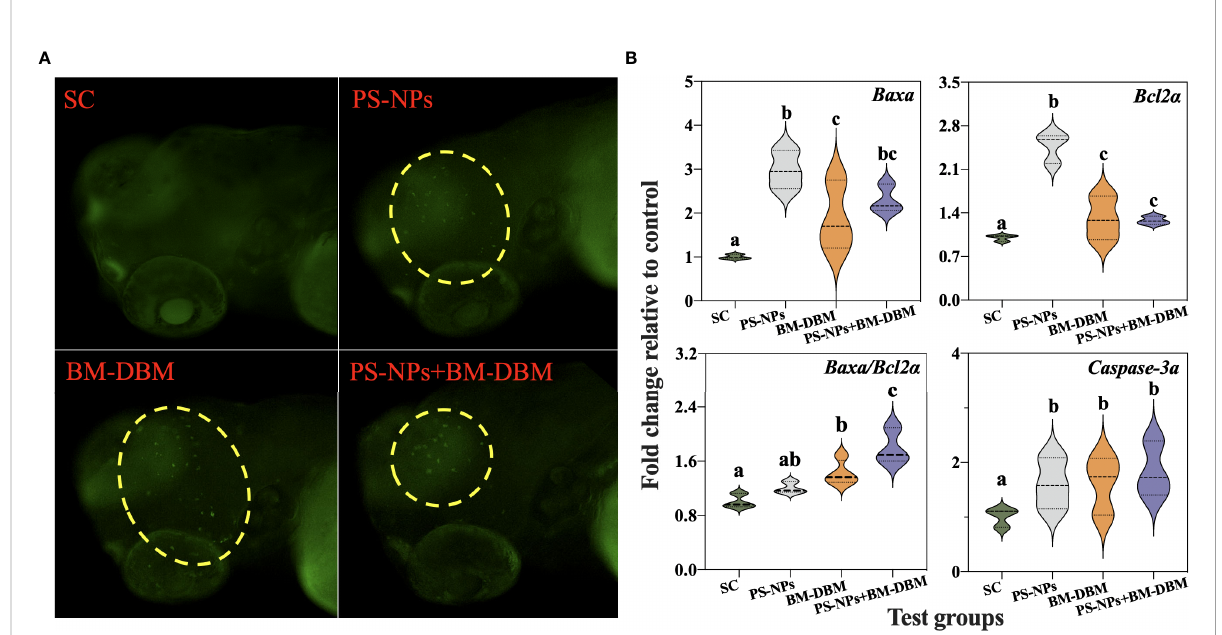
FIGURE 6 Apoptosis (A) and expression of apoptosis-related genes (B) in the CNS of 72 hpf larvae under BM-BDM and PS-NPs exposure alone or in combination. Where green dots represent apoptosis. SC represents the solvent control group. Groups that did not contain the same letter were signi fi cantly different (P <